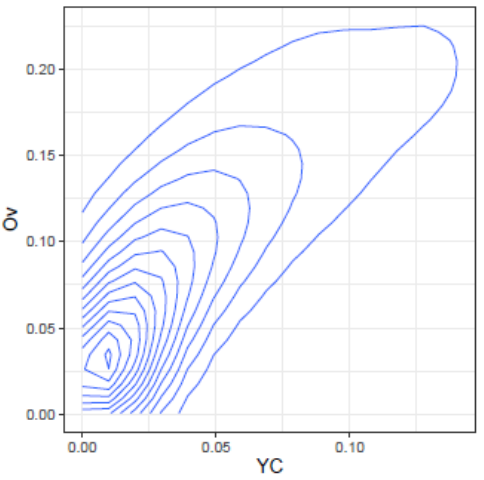
Figure 4. Joint density of Y C and O v .